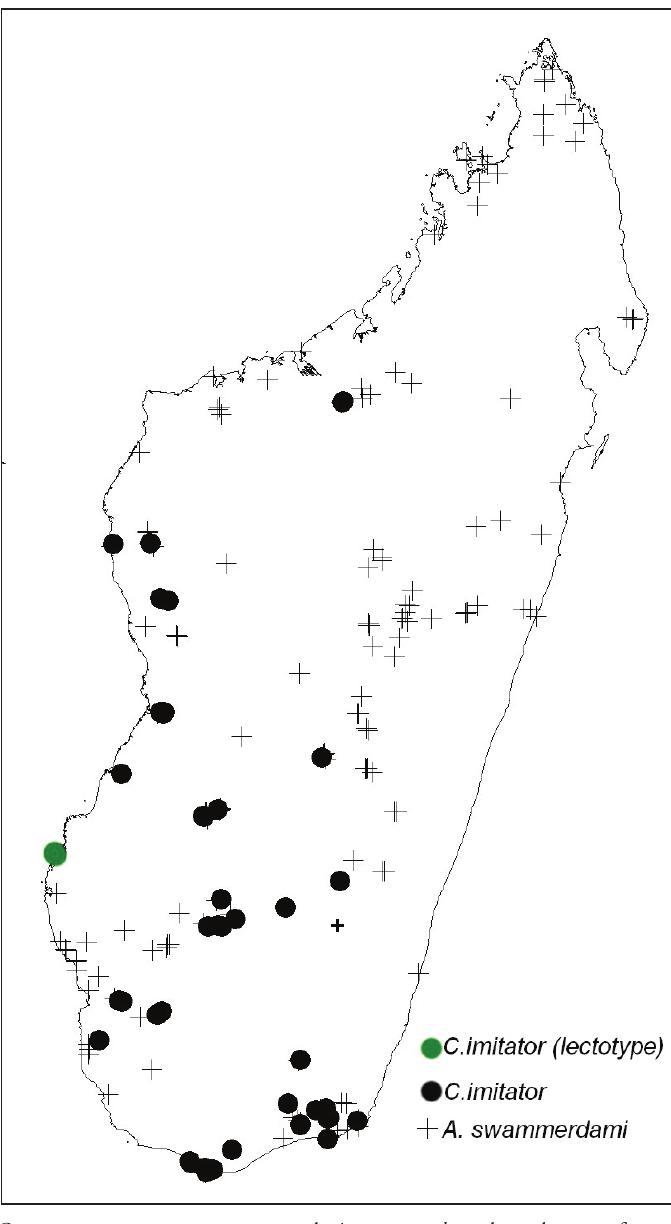
Figure 11. Camponotus imitator is sympatric with A. swammerdami through most of its range. (CASC); Parc National d’Isalo, Ambovo Springs, 29.3 km 4° N Ranohira, -22.29833, 45.35167, 990 m, Uapaca woodland (Fisher, Griswold et al.) (CASC); Ihosy, -22.40317, 46.12917, 735 m, urban/garden (B.L.Fisher et al.) (CASC); Forêt d’Atsirakambiaty, 7.6 km 285° WNW Itremo, -20. 59333, 46.56333, 1550 m, grassland (Fisher,